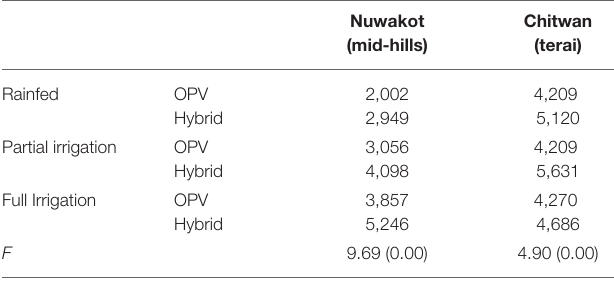
TABLE 5 | Rice yield by seed type, irrigation status and study areas, Nepal (kg/ha, farmer reported).